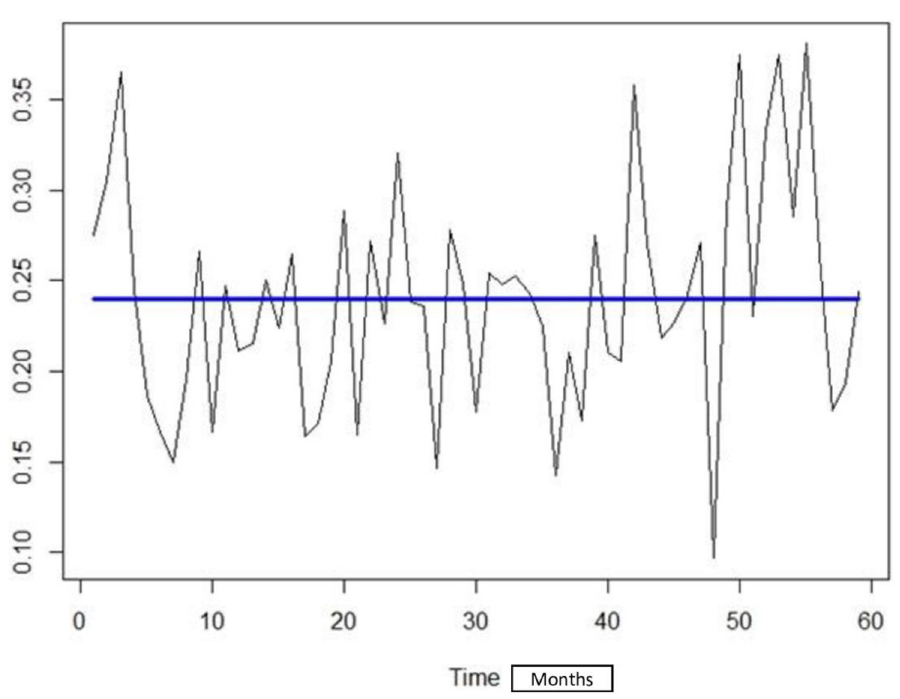
Fig 3. Maternal CMV seroprevalence across all cohort participants from April 2005 to March